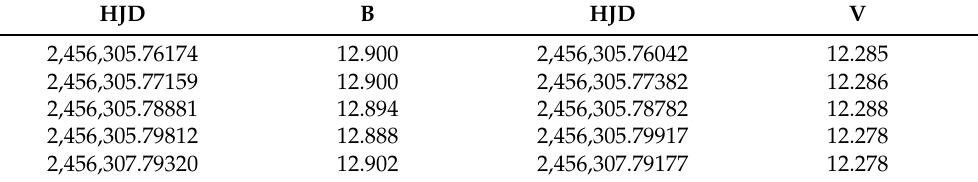
Table 2. Photometry of GSC